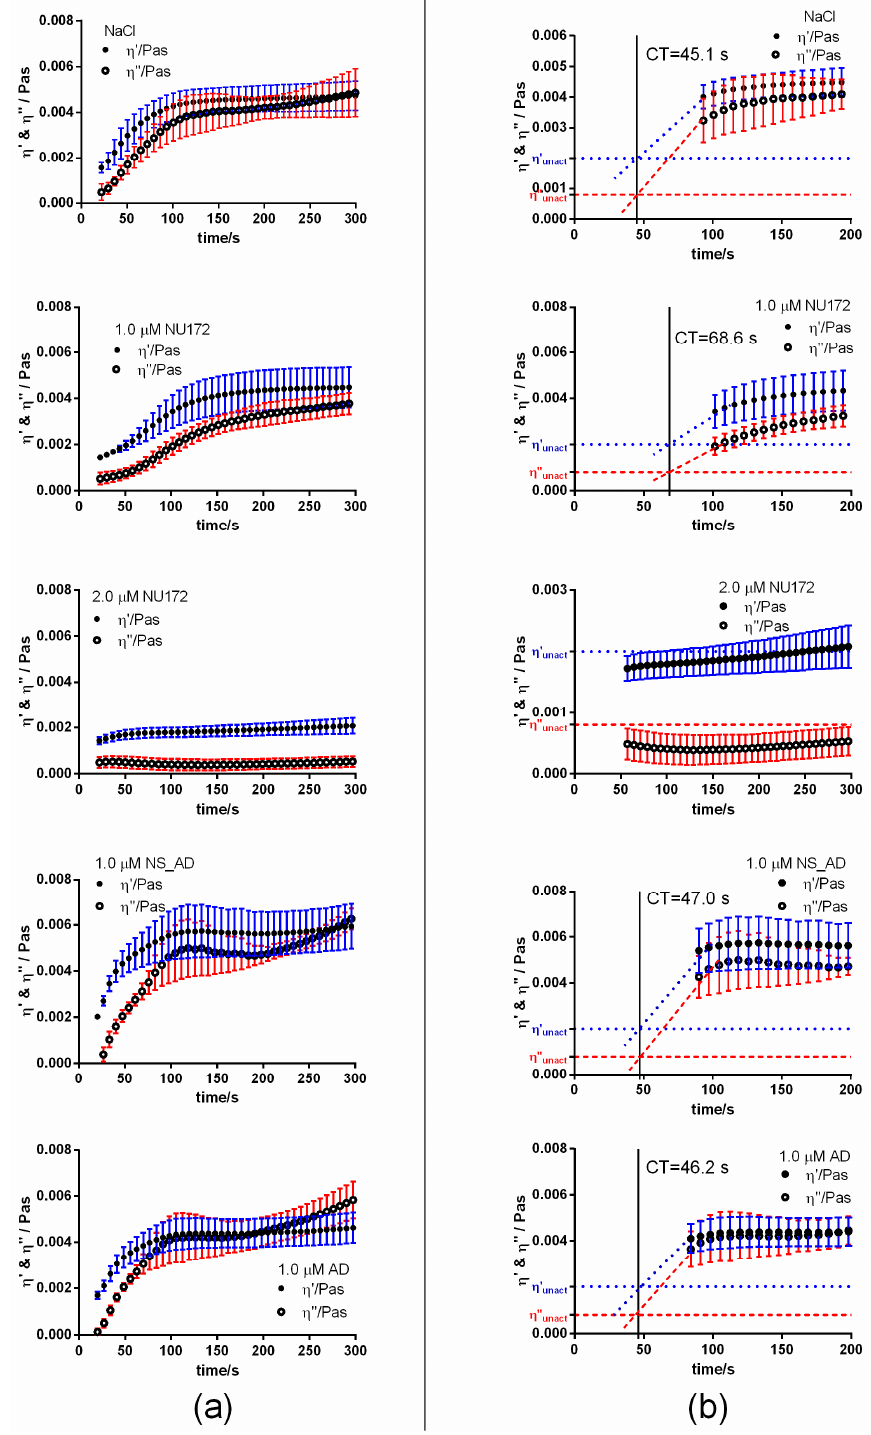
Figure 5. Detection of clotting time (CT) in heparinized blood (1 IU/mL) using PIEZ after the addition of 1.0 or 2.0 µM NU172. Mean viscous ( η ’) and elastic ( η ”) components of blood are shown after the addition of ( a ) NaCl (control), 1.0 or 2.0 µM NU172, 1.0 µM NS_AD, or 1.0 µM AD. The measurements were performed at 100 Hz and at 37 °C (n = 10 ± SD). ( b ) Enlarged parts of diagrams for the calculation of CT. The horizontal dotted blue line at 0.002 Pa·s visualizes the η ’ and the dashed red line at 0.0008 Pa·s visualizes the η ” of unactivated heparinized blood.